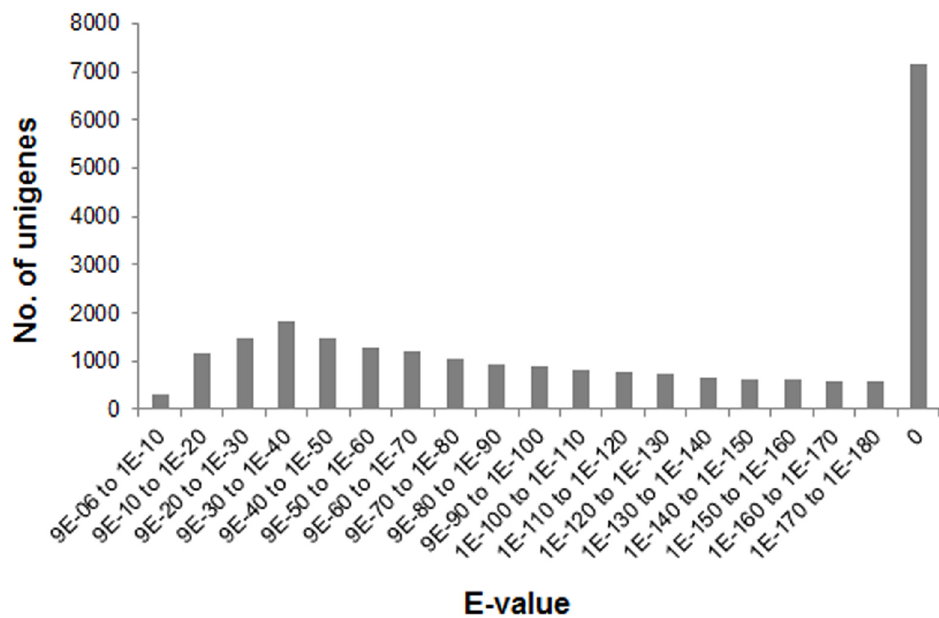
Fig 1. E -value distribution of S . maximus transcriptome unigenes matched to Nr